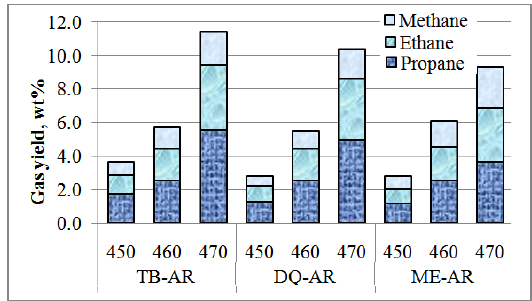
Figure 3. The yield of C